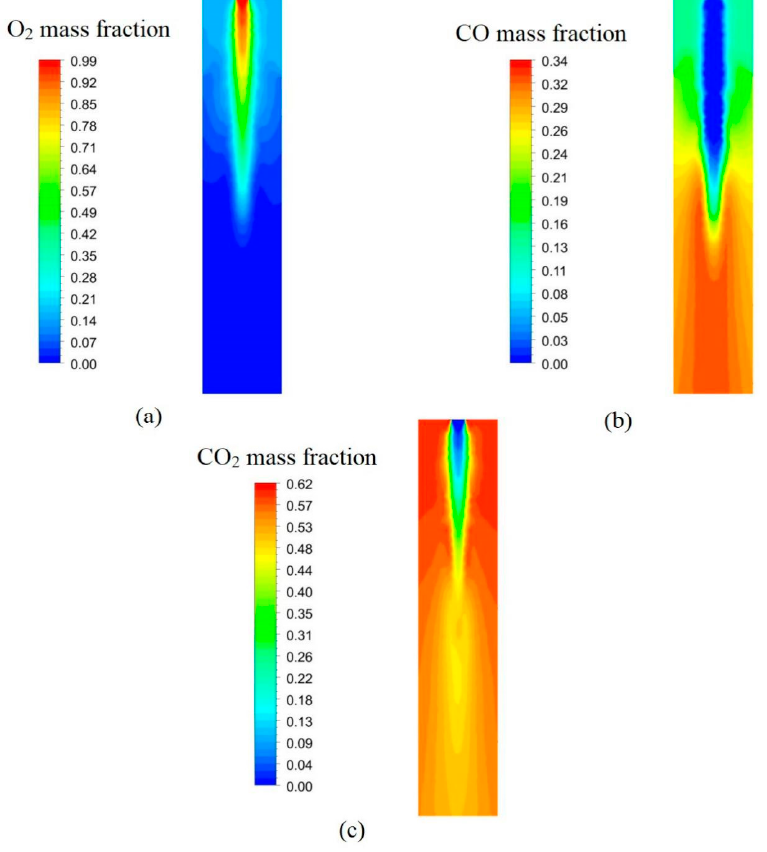
Figure 7. Gas concentration on the symmetry plane of the reaction shaft; ( a ) O 2 ; ( b ) CO and ( c ) CO 2